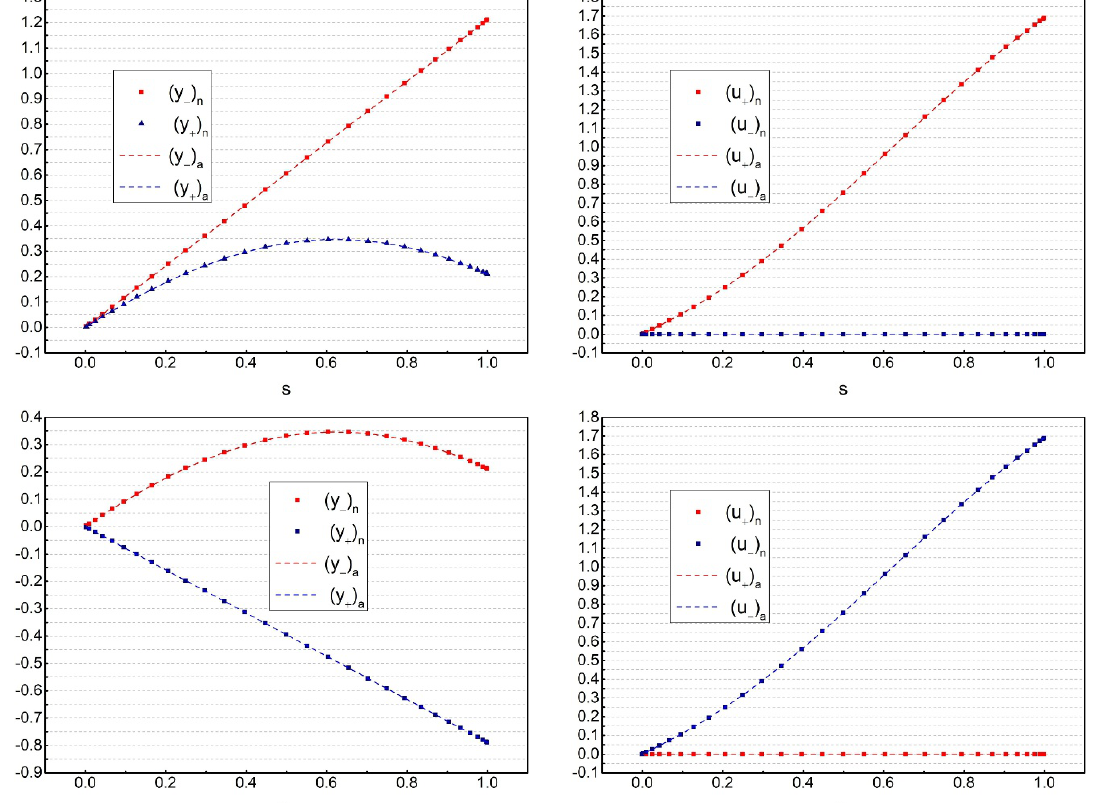
Figure 2 . Comparing the numerical solutions to analytic solutions for the simple geodesics (2.45). The top two graphs show the geodesic ending at y +1 = 0 : 211, y (cid:0) 1 = 1 : 211, u +1 = 1 : 690, u (cid:0) 1 = 0, while the bottom two graphs show the geodesic ending at y +1 = (cid:0) 0 : 790, y (cid:0) 1 = 0 : 211, u +1 = 0, u (cid:0) 1 = 1 : 690. These values were chosen to produce simple values for (cid:3) + and (cid:3) (cid:0) , i.e., (cid:3) + = (cid:3) (cid:0) = 1. The subscripts \n" and \a" are used to indicate the numerical and analytical solutions,